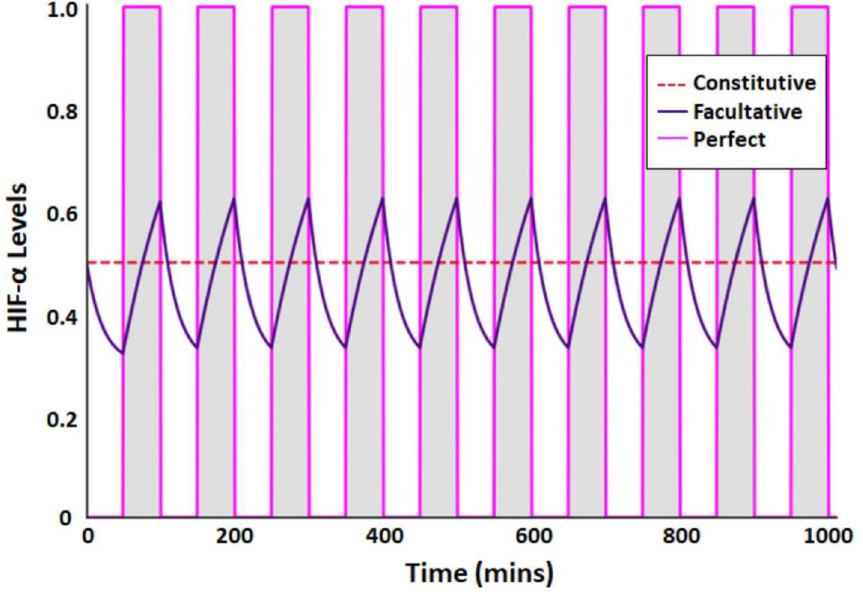
Figure 7. Comparison of 3 HIF-α response strategies to changes in oxygen supply within the tumor (cell) microenvironment. The perfect strategy is instantaneous and used as an upper bound for comparison. Constitutive is constant over time, and facultative has a rate-limited response. The unshaded areas represent periods of full oxygenation while the shaded grey areas represent periods of